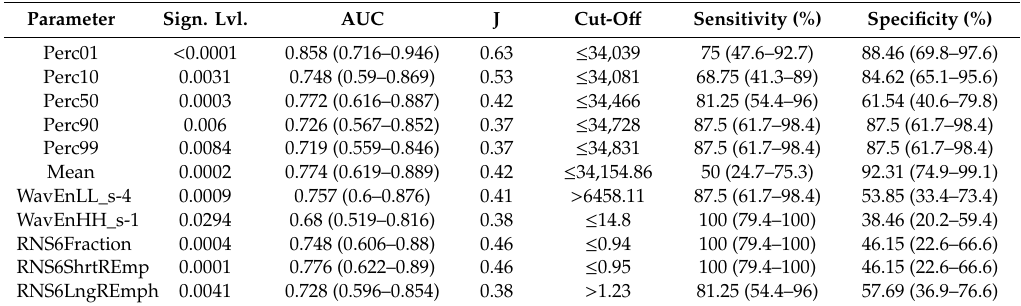
Table 3. Receiver operating characteristic (ROC) analysis results of the texture parameters in high-grade gliomas’ assessment.